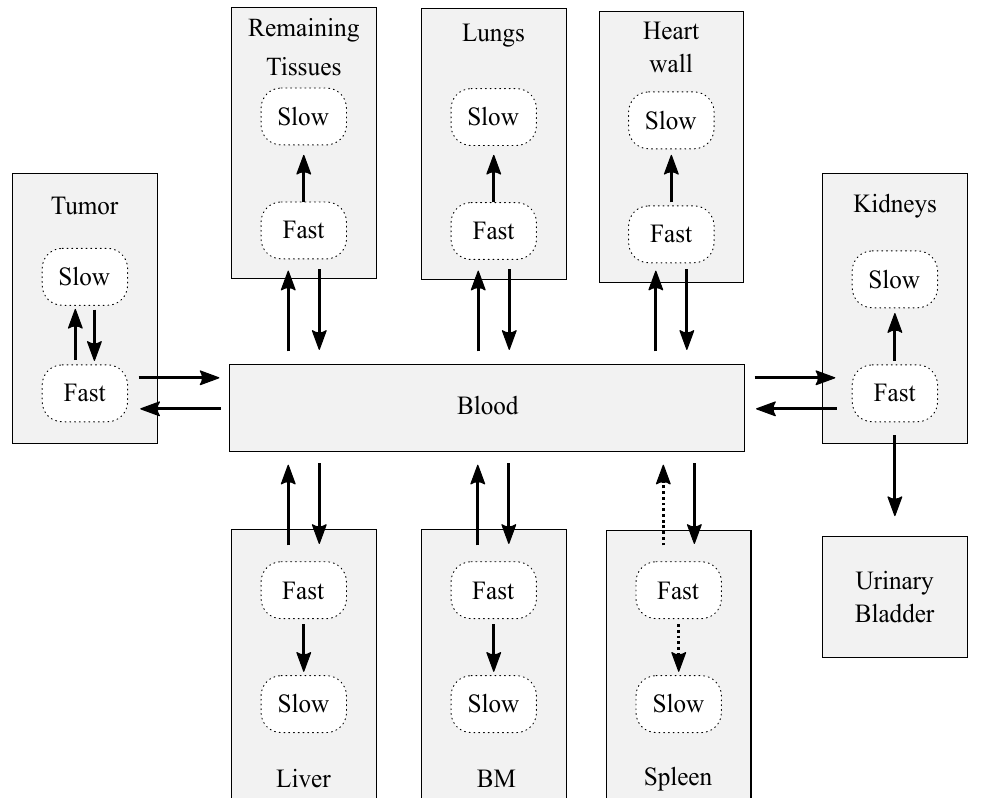
Figure 3. Sketch of the biokinetic model proposed for CLR1404. The dotted arrows represent those contributions that were initially considered after the decoupling analysis, but which were later discarded after the data fitting and sensitivity analysis. The solid arrows represent the exchange paths of the final